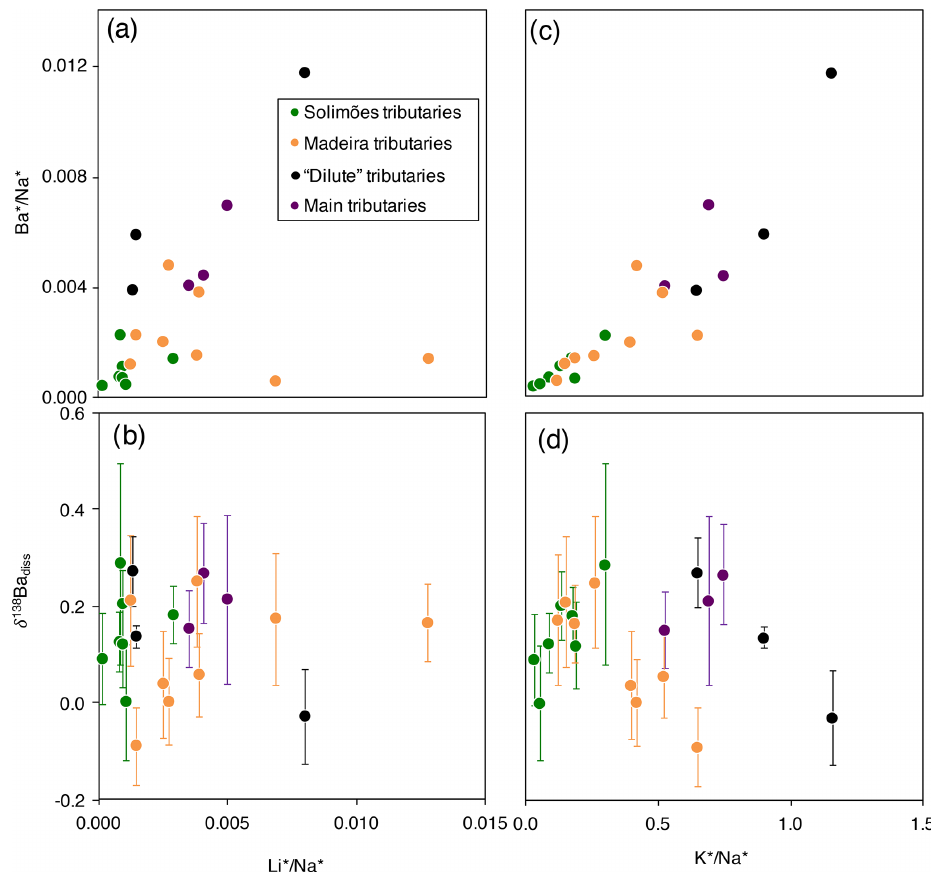
Figure 3. Scatter plots of Ba ∗ / Na ∗ and δ 138 Ba diss vs. Li ∗ / Na ∗ and K ∗ / Na ∗ for the dissolved load of the Amazon rivers (“ ∗ ” refers to the dissolved element concentration corrected for non-silicate inputs; see Appendix A for